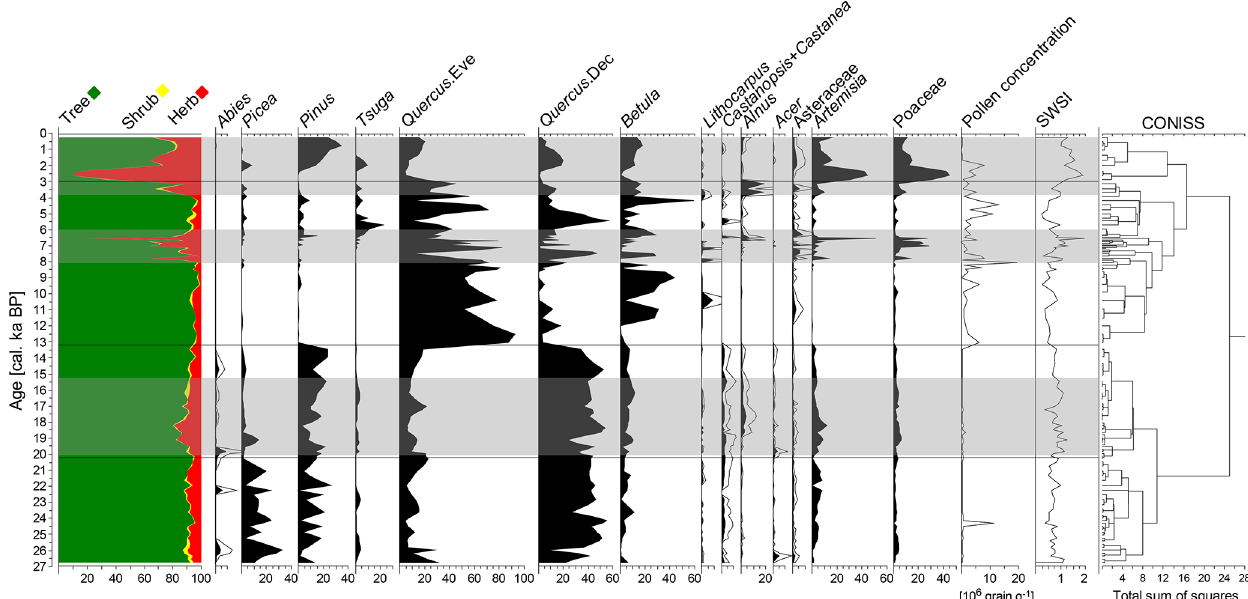
Figure 4. Pollen percentages diagram of the main taxa (average percentages ≥ 5%), the pollen concentration and the reconstructed soil water stress index (SWSI). Pollen types with relatively low percentages have been magnified 3 times. Grey shadows mark periods of relatively high